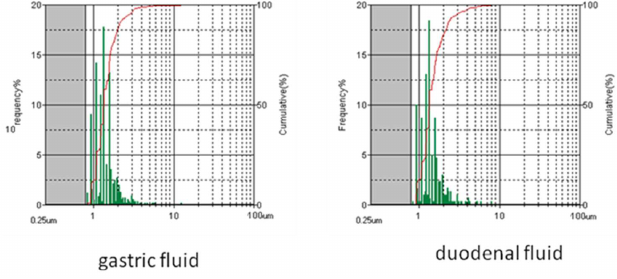
Figure 3. Size distribution (green) and cumulative size distribution (red) for TiO 2 -NM1 in vitro digestion cascade measured by the flow particle imaging